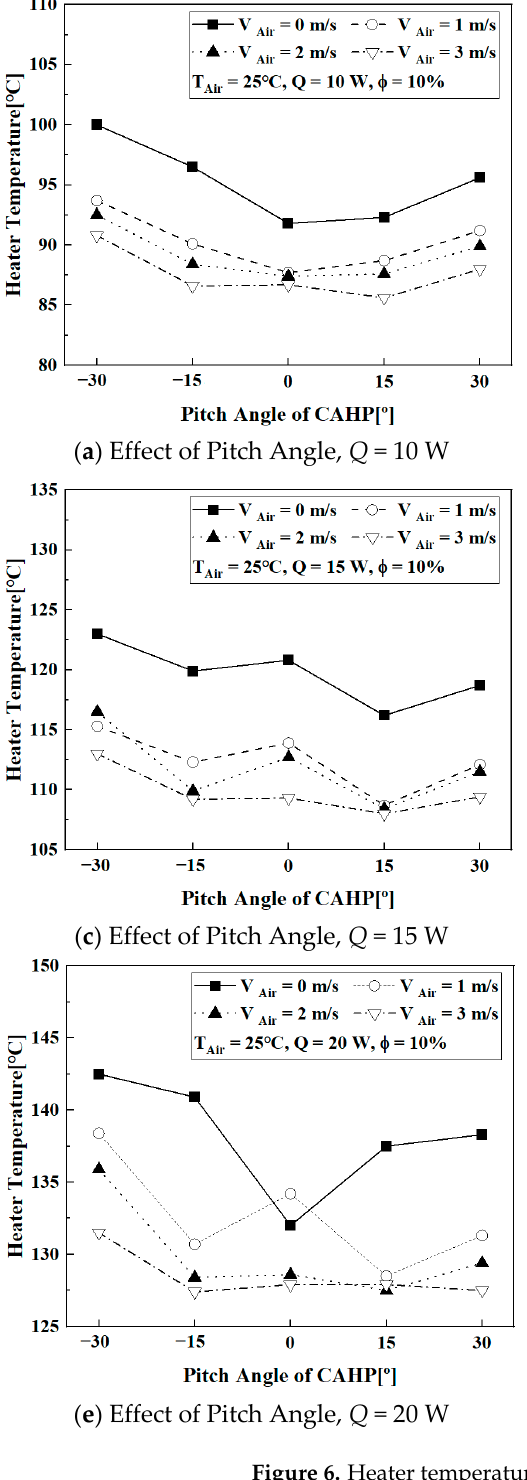
Figure 6. Heater temperature according to Q , V air , pitch angle, and roll angle ( ∅ = 10%). Considering the results according to the roll angle, the best operating condition of the CAHP was a roll angle of 30° and a V air of 2